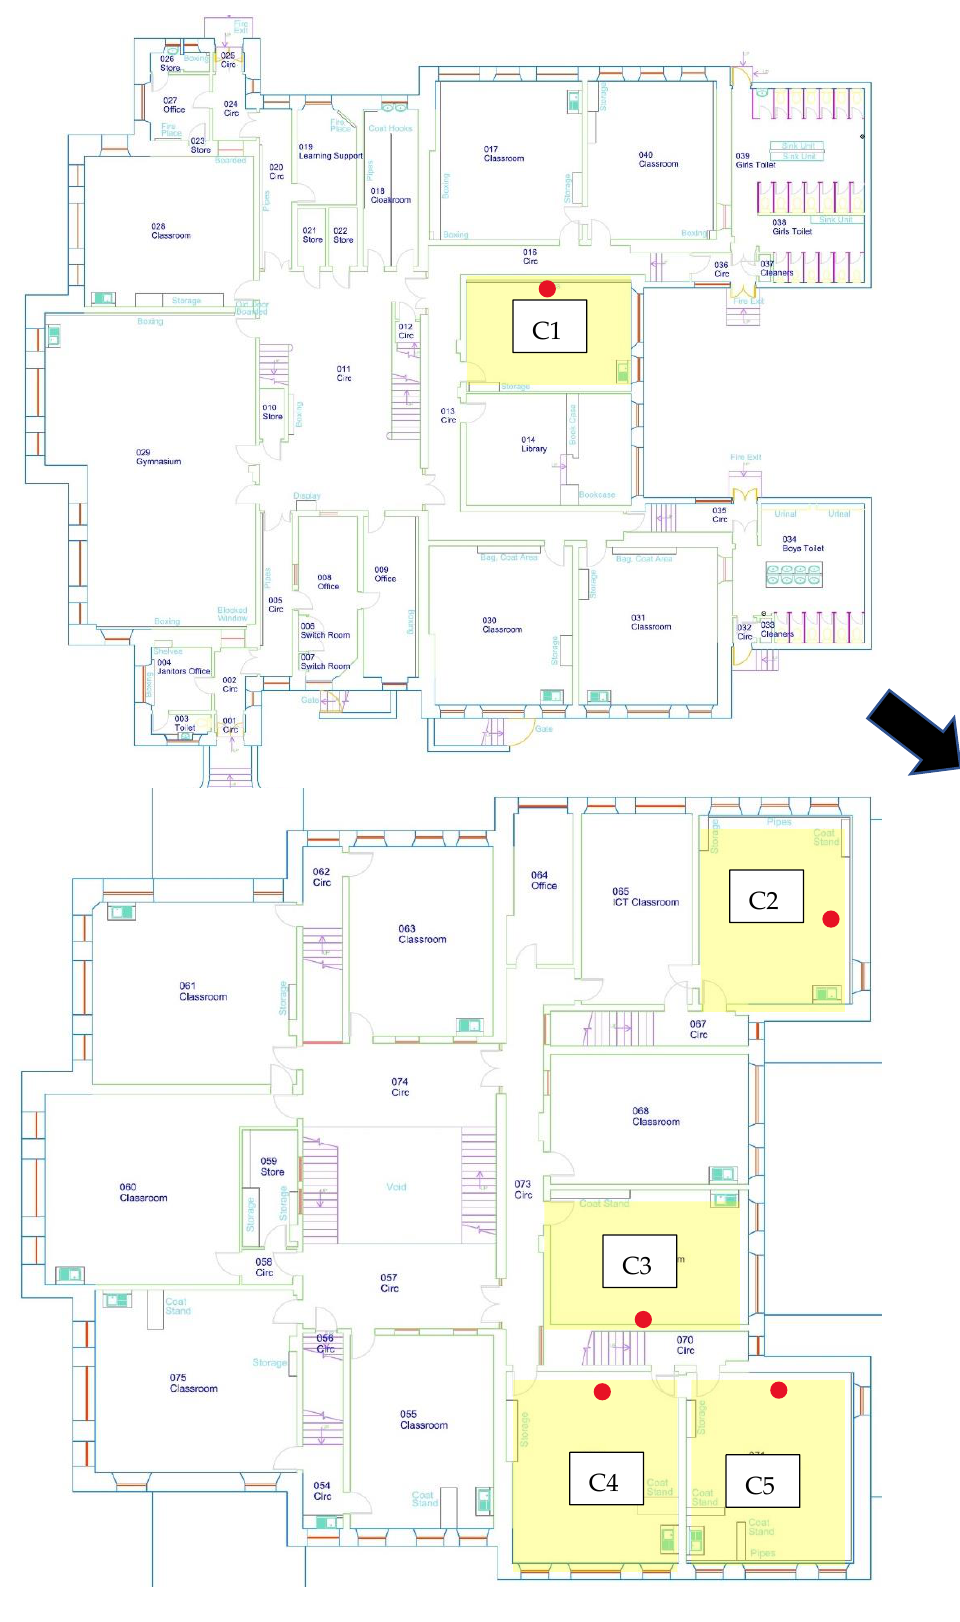
Figure 9. School C.